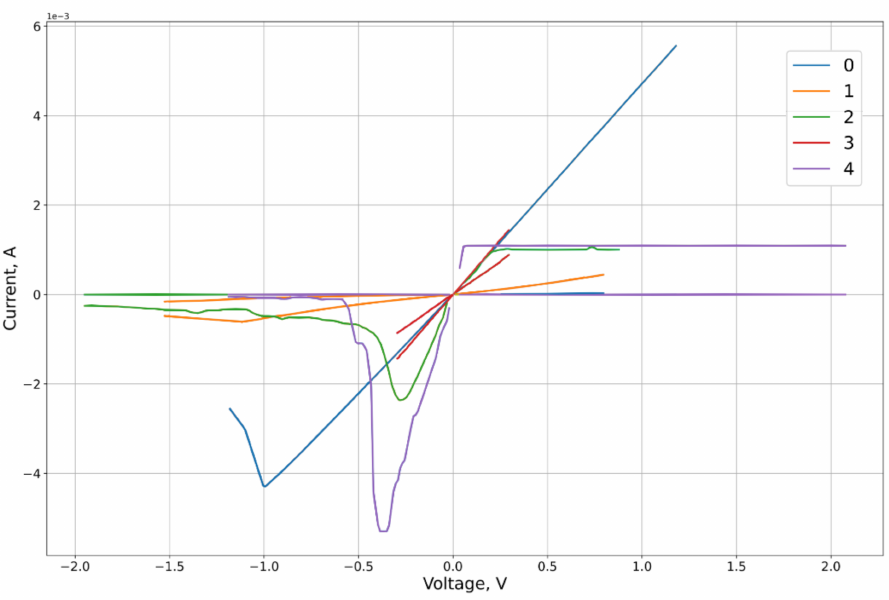
Figure 3. Model asymmetric elements of I-V